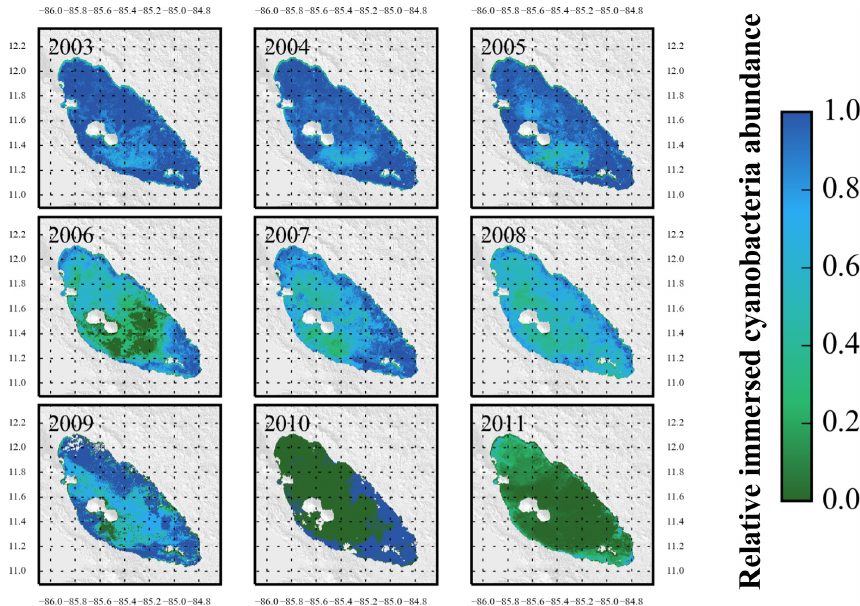
Figure 15. Annual relative cyanobacteria abundance in Lake Nicaragua, 2003–2011 ( immersed_cyanobacteria_mean ). Note that the number and distribution of valid observations across the years are quite unequal (Fig. 16).